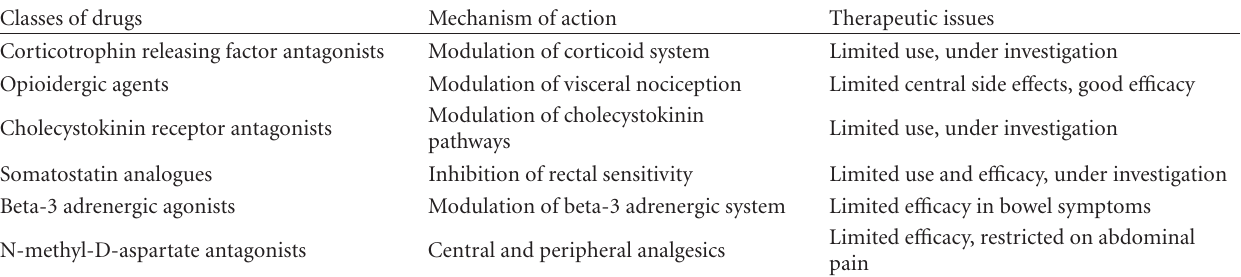
Table 2: Novel psychotropic agents used for the treatment of irritable bowel